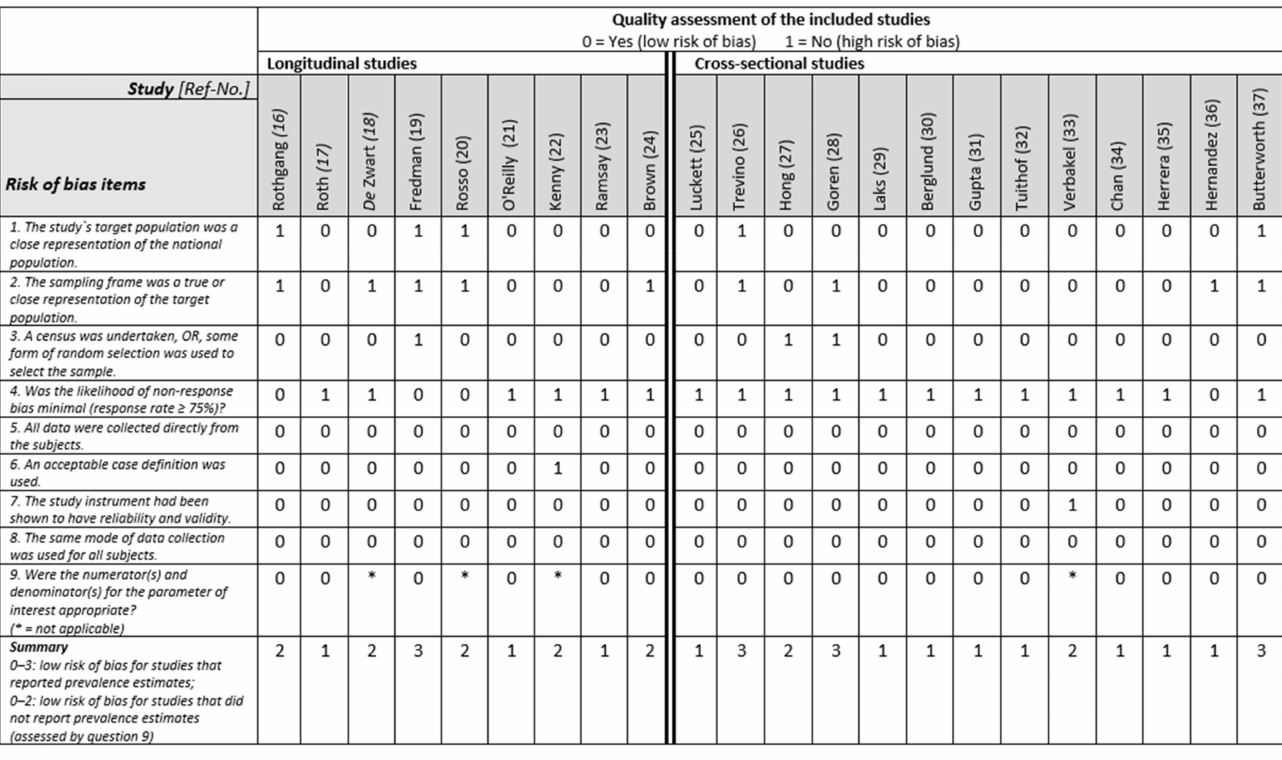
Figure 2. Overview of the quality assessment of the included studies based on the risk of bias criteria as suggested by Hoy et al.